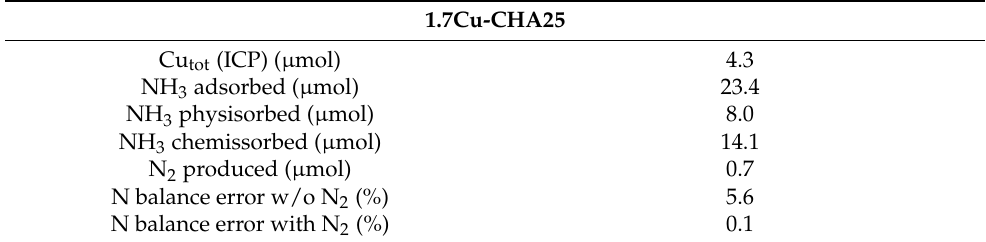
Table 1. Integral balances for the NH 3 adsorption + TPD test over 1.7Cu-CHA25 shown in Figure 1.